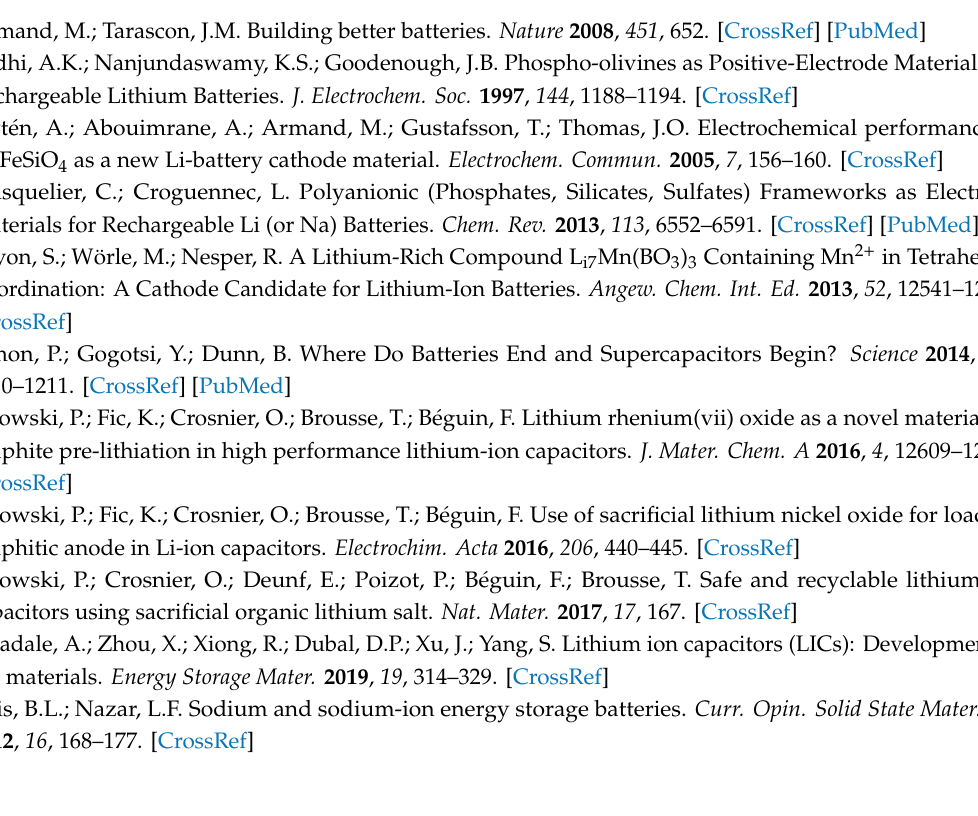
Table S1: Interatomic potential parameters used in the atomistic simulations of NaFeO 2 ; Table S2: Energetics of intrinsic defect process in NaFeO 2 ; Table S3: Solution enthalpy for dopant substation at Fe site in NaFeO 2. Author Contributions: Computation, N.K. (Navaratnarajah Kuganathan) and N.K. (Nikolaos Kelaidis);